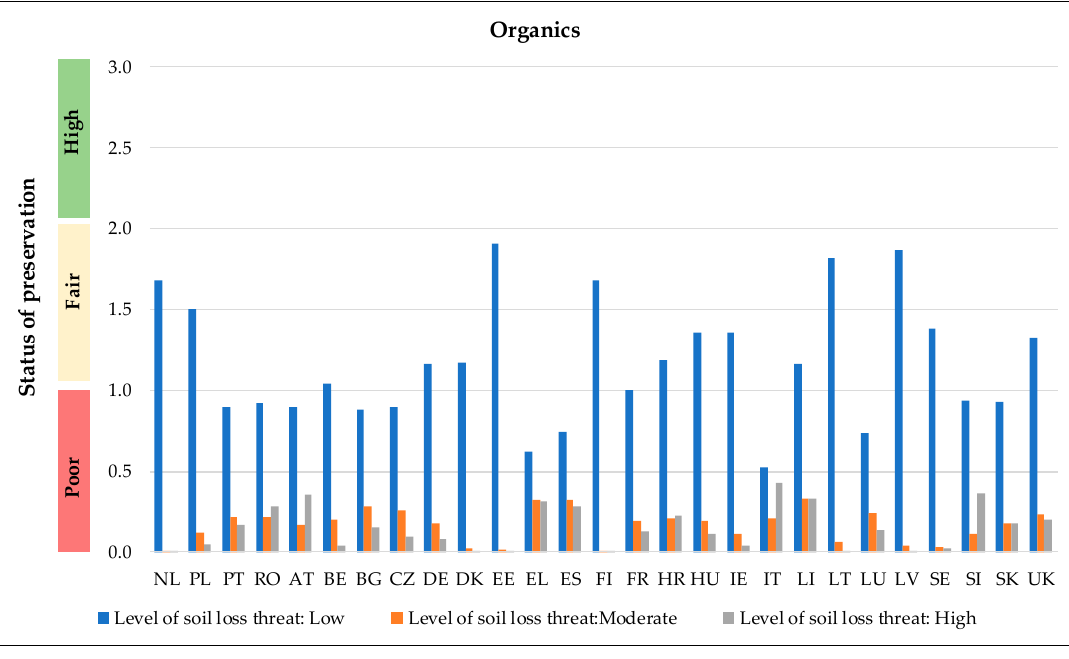
Figure 9. Mean values per country level for organics per level of soil-loss threats: Values close to 1 indicate poor status of preservation, values close to 2 indicate fair conditions of preservation, and values close to 3 good preservation status.